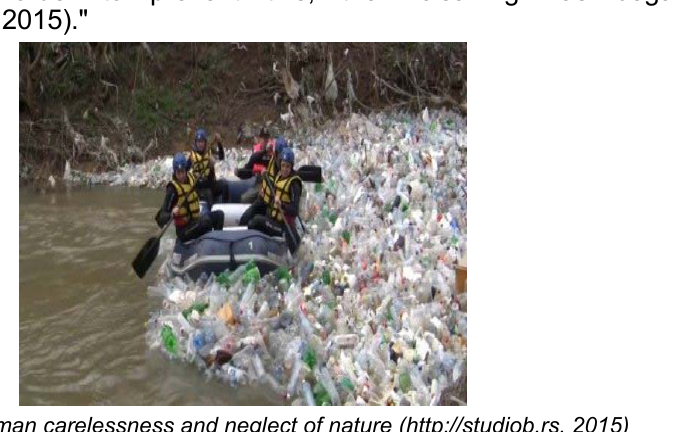
Figure 3 – Human carelessness and neglect of nature (http://studiob.rs, 2015) Рис . 3 – Небрежное и безответственное отношение человека к природе (http://studiob.rs, 2015) Слика 3 – Људска небрига и немар према природи (http://studiob.rs,